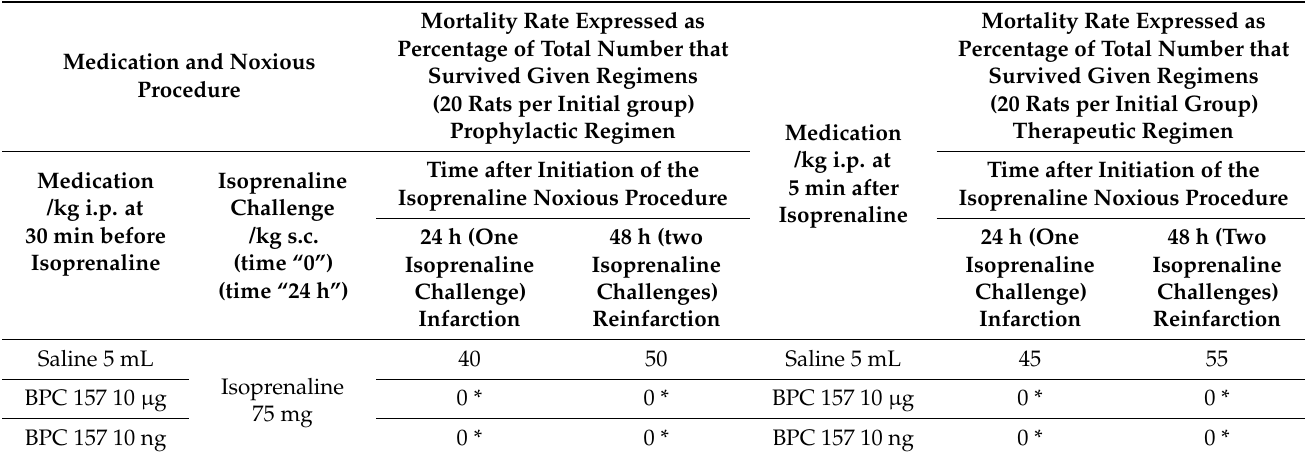
Table 3. Mortlity rate (expressed as percentage of total number that survived given regimens (20 rats per initial group)) in isoprenaline-treated rats treated with BPC 157, L-arginine, and L-NAME, given alone or together. Prophylactic regimen. Therapeutic regimen. Isoprenaline (75 mg/kg or 150 mg/kg s.c., given once (at time 0) or twice, at 0 and 24 h). First challenge for initial infarction induction, assessed at 24 h thereafter; and then at the point of 24 h, the next application (isoprenaline given twice, at 0 and 24 h) for reinfarction induction (assessment at the end of the subsequent 24 h period). Medication (/kg, i.p.) (BPC 157 (10 µ g, 10 ng), L-NAME (5 mg), L-arginine (200 mg) (given alone or together) or saline (5 mL) (control)) at (i) 30 min before; or, alternatively (ii) at 5 min after isoprenaline. vs. control, * at least p < 0.05, 10 rats per each experimental